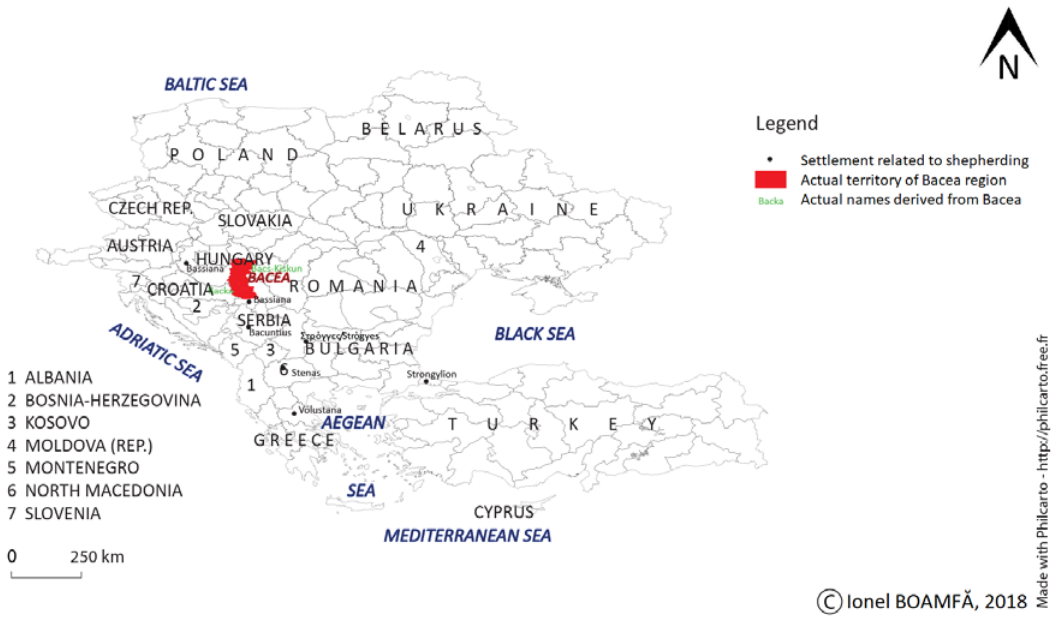
Figur e 15. Distribution of names from the Antiquity related to shepherding in the Carpathian- Balkan